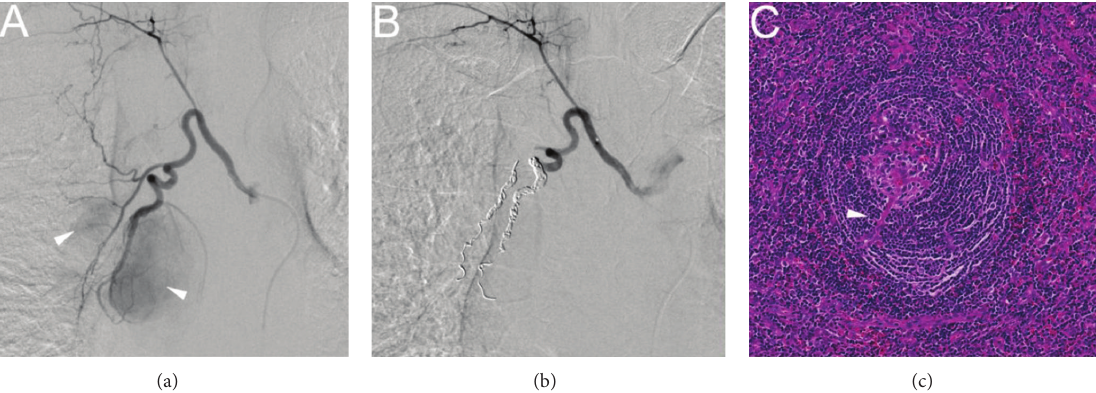
Figure 2: (a) and (b) Aortic angiogram with selective bronchial arteriogram demonstrated the tumor as a dense capillary blush, the arterial supply of which originated mainly from the branches of the right bronchial artery (arrowhead) (a). Embolization of feeding branches resulted in the near complete occlusion of the tumor vessels (b). (c) Histopathology of surgical specimen. The tumor was composed of lymphoid follicles with an expanded mantle zone forming concentric rings (i.e., an “onion-skin” pattern) and hyalinized vascular proliferation penetrating the lymphoid follicle (i.e., a “lollipop” appearance, arrowhead) (hematoxylin-eosin (HE) stain, ×